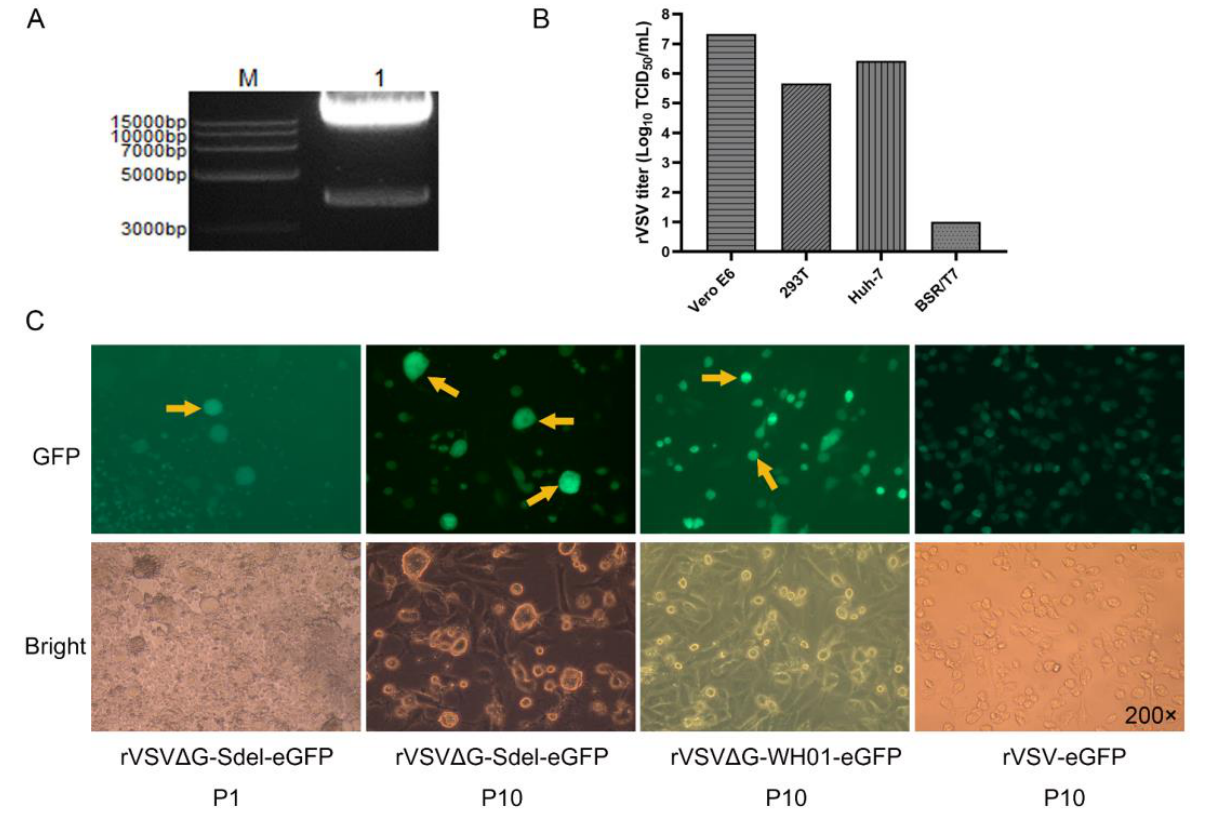
Figure 2. Generation and characterization of rVSV ∆ G-Sdel-eGFP. ( A ) Enzymatic digestion identification of the pcDNA3.1-VSV ∆ G-Sdel plasmid. ( B ) Infectivity of rVSV ∆ G-Sdel-eGFP on four types of cell lines. Infectivity was quantified by testing TCID 50 in the above cell lines. ( C ) Diagram of cytopathic differences between rVSV ∆ G-Sdel-eGFP, rVSV ∆ G-WH01-eGFP and rVSV-eGFP in BSR/T7 cells (P1) and Vero E6 cells (P10). P represents passage.